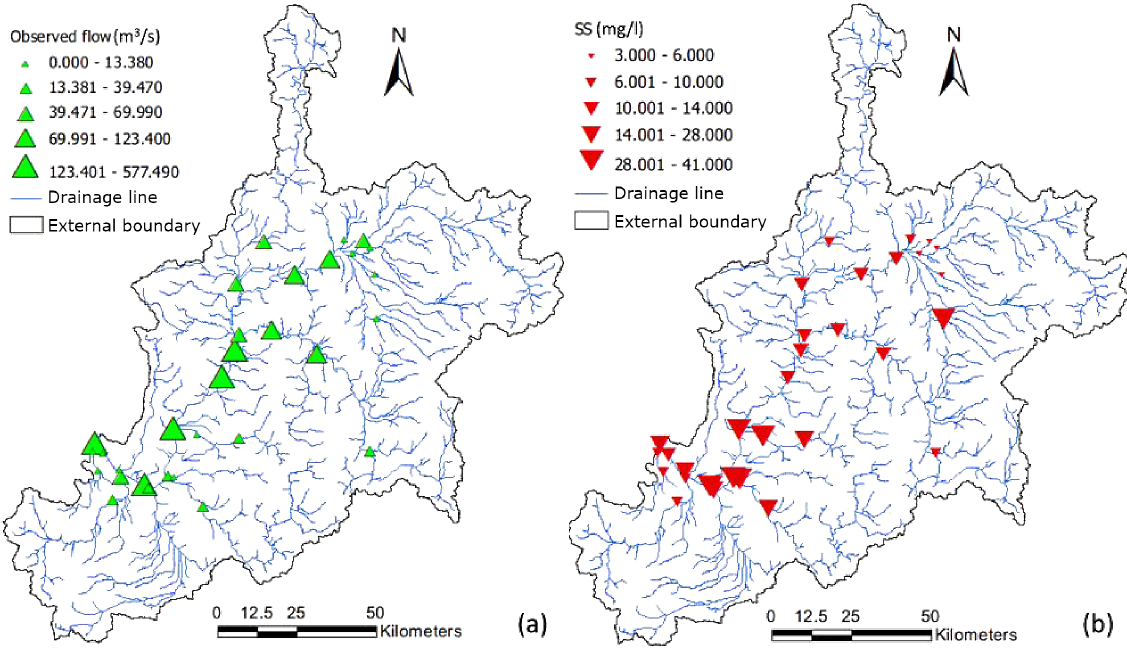
Figure 3. Schematic showing (a) the observed water flows (m 3 s − 1 ) and (b) the observed SS concentration (mgL − 1 ) at 31 monitoring